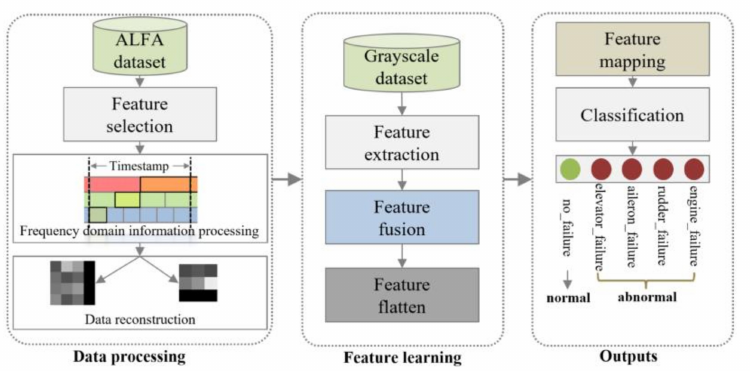
Figure 2. The block diagram of the proposed TS-MSCNN.